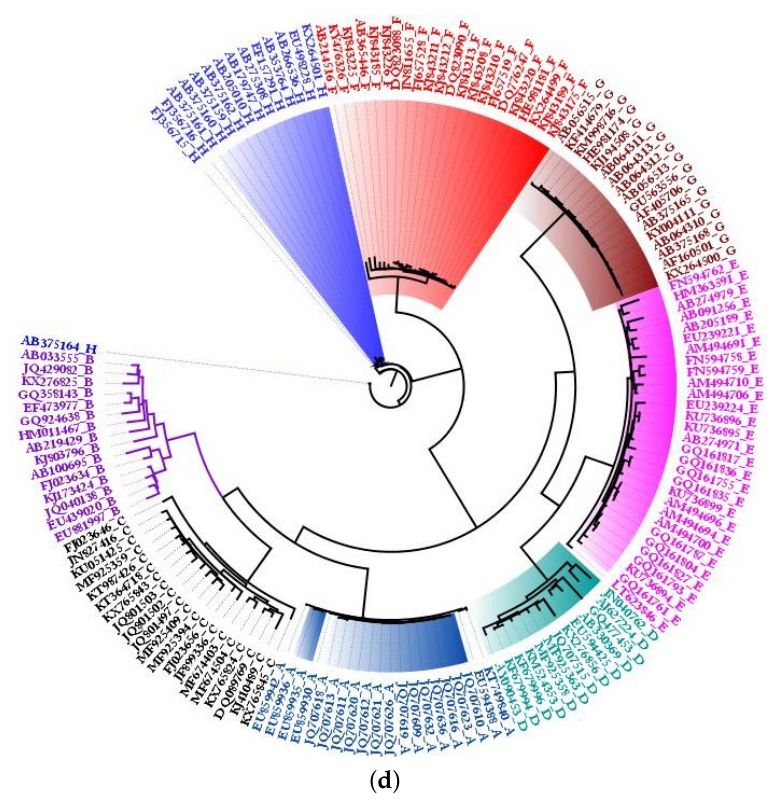
Figure 2. ( a ) The Neighbor-Joining phylogenetic tree of 152 HBV genome sequences based on PCNV method. ( b ) The Neighbor-Joining phylogenetic tree of 152 HBV genome sequences based on FFP method (k = 5). ( c ) The Neighbor-Joining phylogenetic tree of 152 HBV genome sequences based on NV method. ( d ) The phylogenetic tree of 152 HBV genome sequences based on Bayesian inference method.